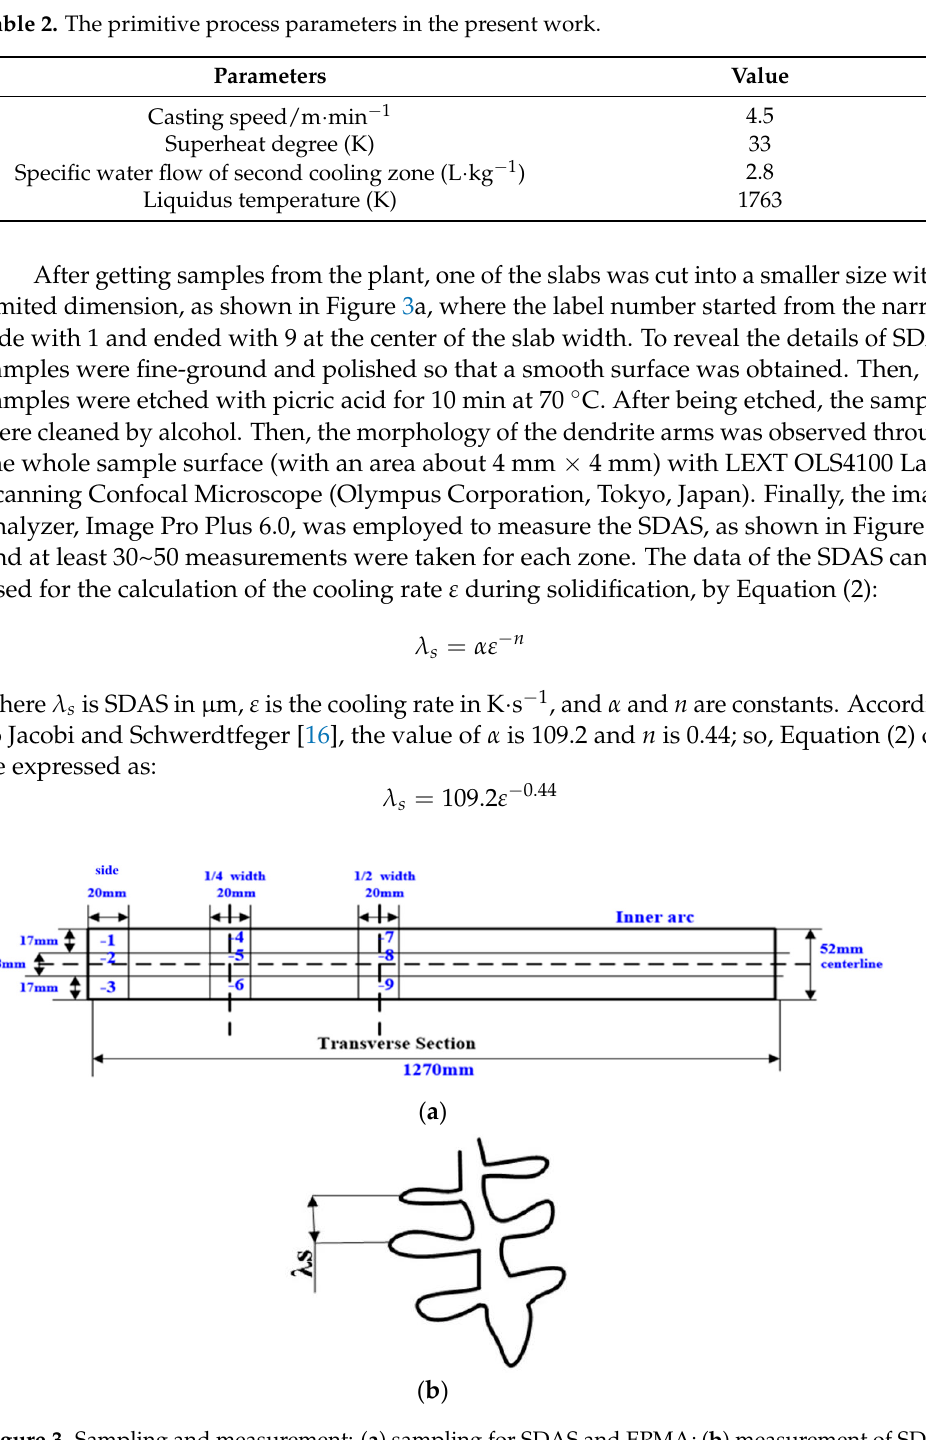
Figure 4. Testing position for OES. 3. Results and Discussion 3.1. Morphology of Solidifying Structure Figure 5 shows the morphology of the solidifying structure produced by the CSP process. As shown in Figure 5, the solidifying structure consisted of a chill zone a few millimeters beneath the surface (Figure 5a,c) and a coarsened columnar dendrites’ zone after the chill zone towards the center of the studied slabs (Figure 5b). It is obvious that, unlike attempting to enlarge the equiaxed zone during a conventional continuous cast process [17–23], the centerline of slabs produced by the CSP process was occupied by co- lumnar dendrites (Figure 5b). The fine chill zone reflected the solidification with a rapid cooling rate in the meniscus, beyond which the columnar dendrites became coarsened towards the center of the slab. The orientation of the columnar dendrites illustrated that the direction of heat extraction was almost vertical to the surface of the slab; in other words, the solidification that occurred in the CSP process can be treated as one-dimension heat extraction.